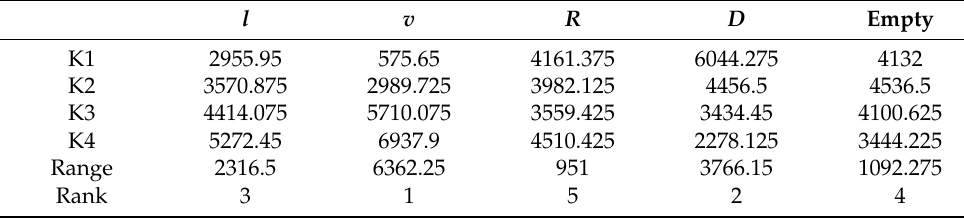
Table 5. Pressure loss ( ∆ p ) range